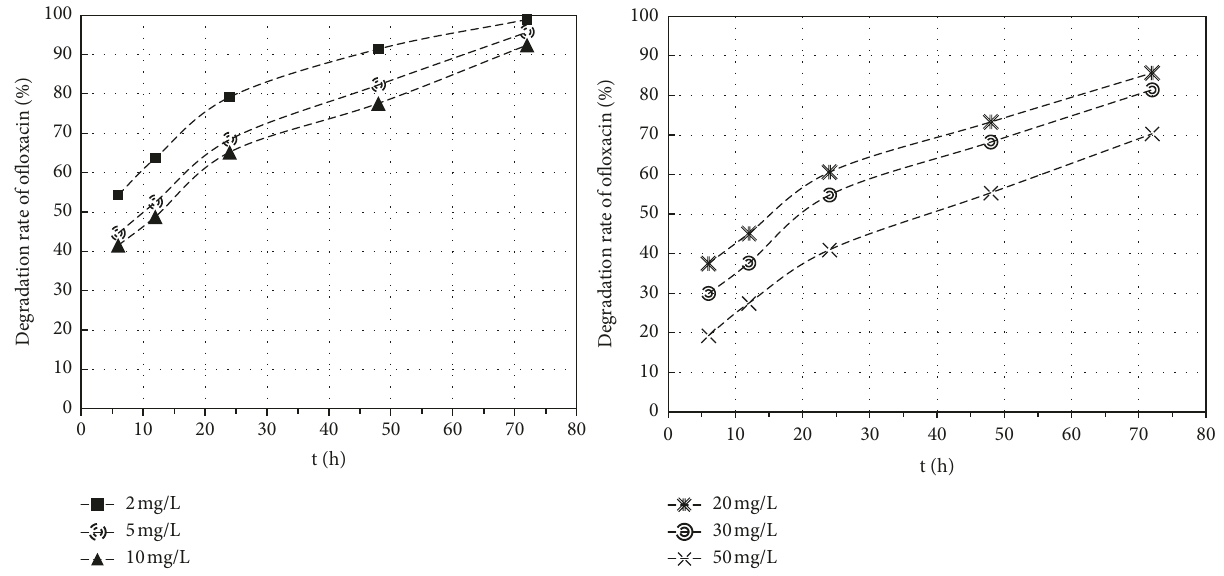
Figure 8: The effect of the initial concentration of ofloxacin on the degradation rate of ofloxacin. Table 2: The effect of initial pH on the degradation rate of ofloxacin.